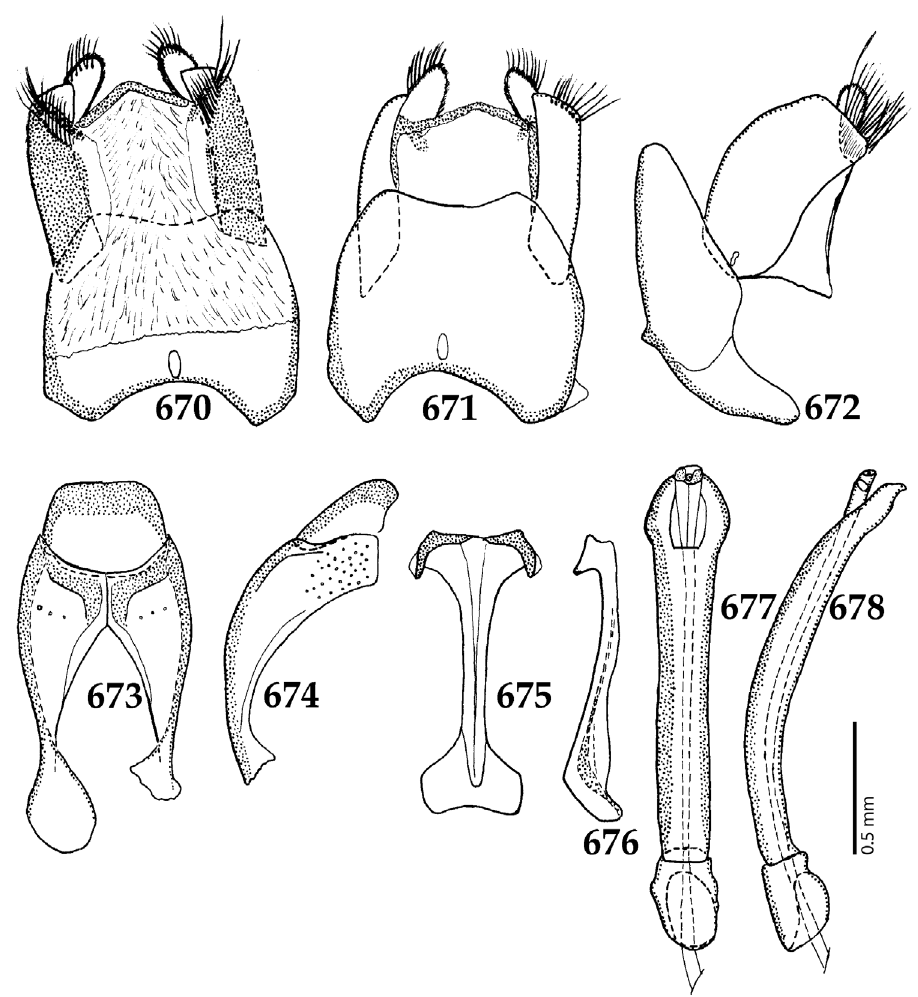
Figures 670–678. 670 Tomogenius kuscheli Dahlgren, 1976 male terminalia: 8 th sternite + 8 th tergite, ventral view 671 ditto, dorsal view 672 ditto, lateral view 673 male terminalia: 9 th + 10 th tergites, dorsal view 674 ditto, lateral view 675 male terminalia: spiculum gastrale, ventral view 676 ditto, lateral view 677 male terminalia: aedeagus, dorsal view 678 ditto, lateral